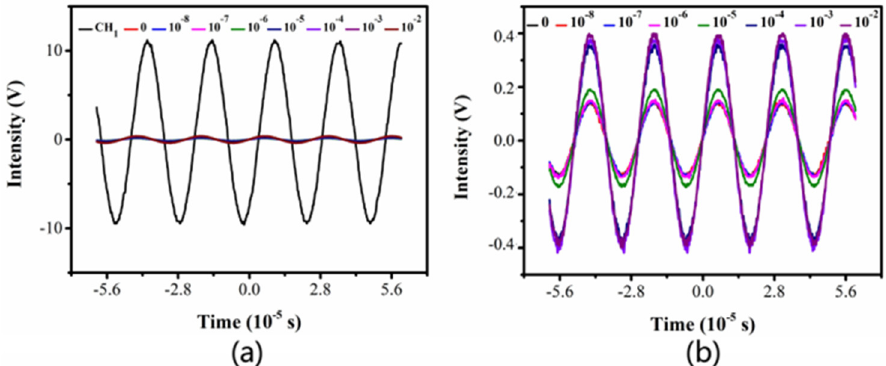
Figure 6. Signal waveform of 0–10 mM KCl solution at the input and output ends of the detection cell. ( a ) The input and output ends; ( b ) The output end. cell. ( a ) The input and output ends; ( b ) The output